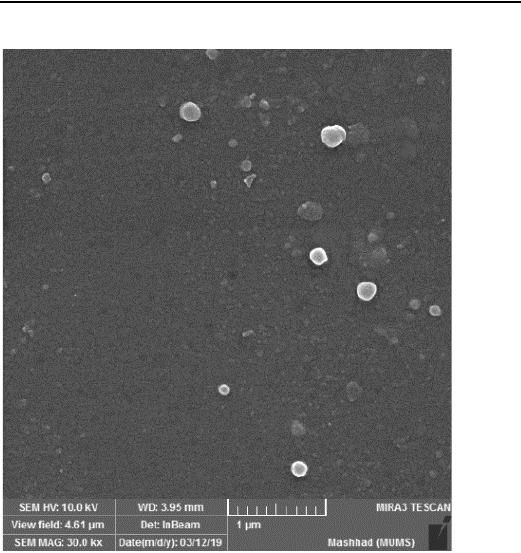
Particle Size (nm)